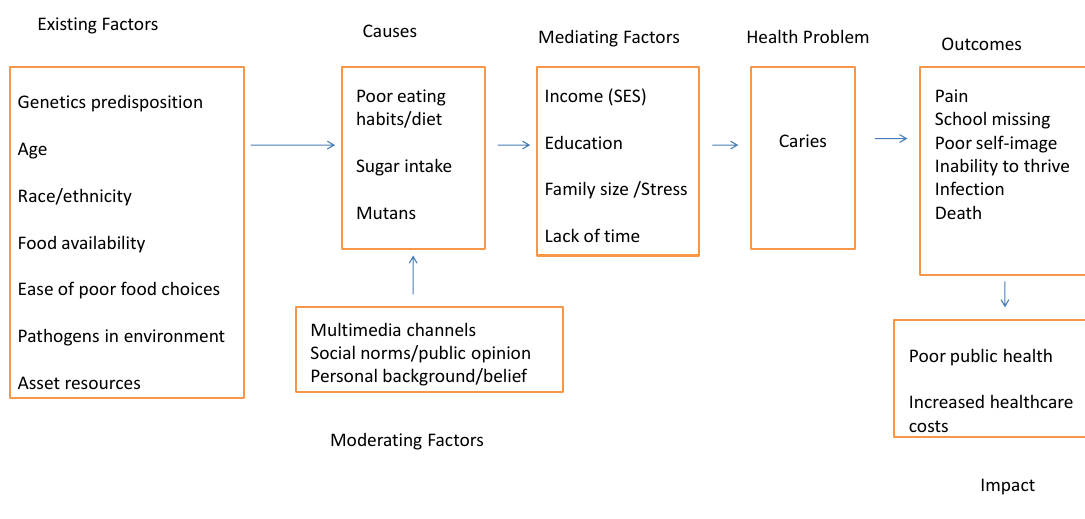
Figure 1. Causal theory applied to the problem of caries in Tabuk, Saudi